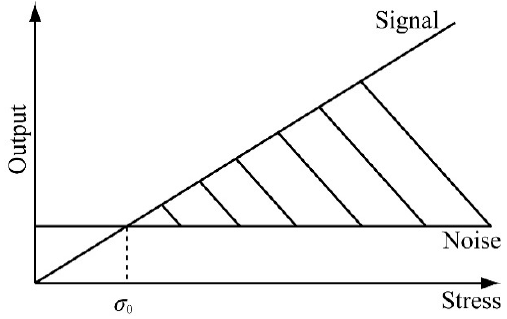
Figure 17. Relationship between the output signal and noise.